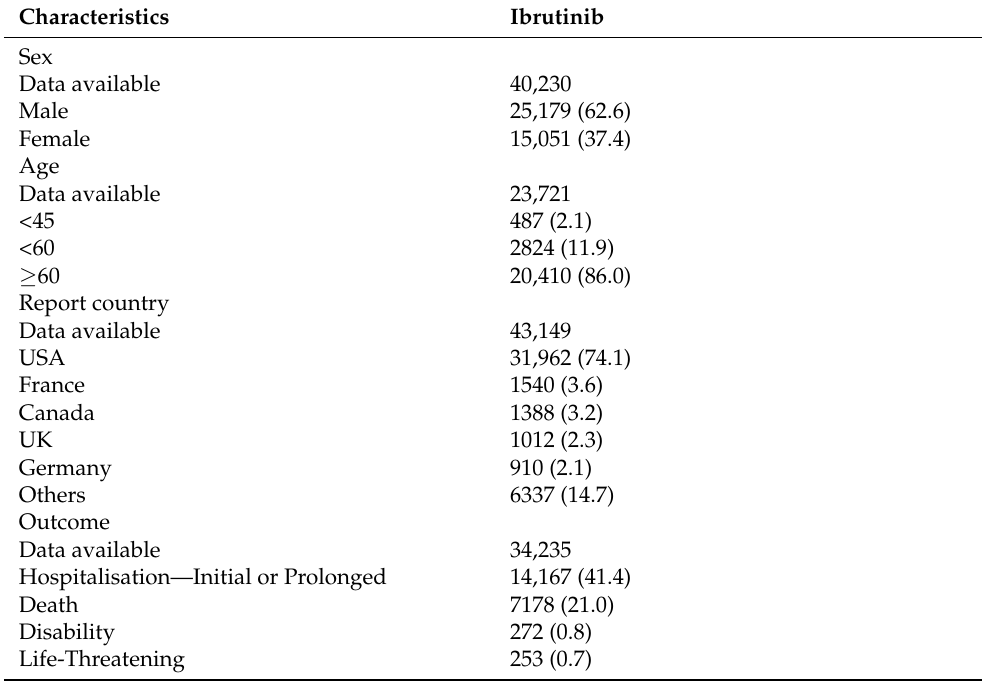
Table 1. Characteristics of records associated with Ibrutinib in FAERS from